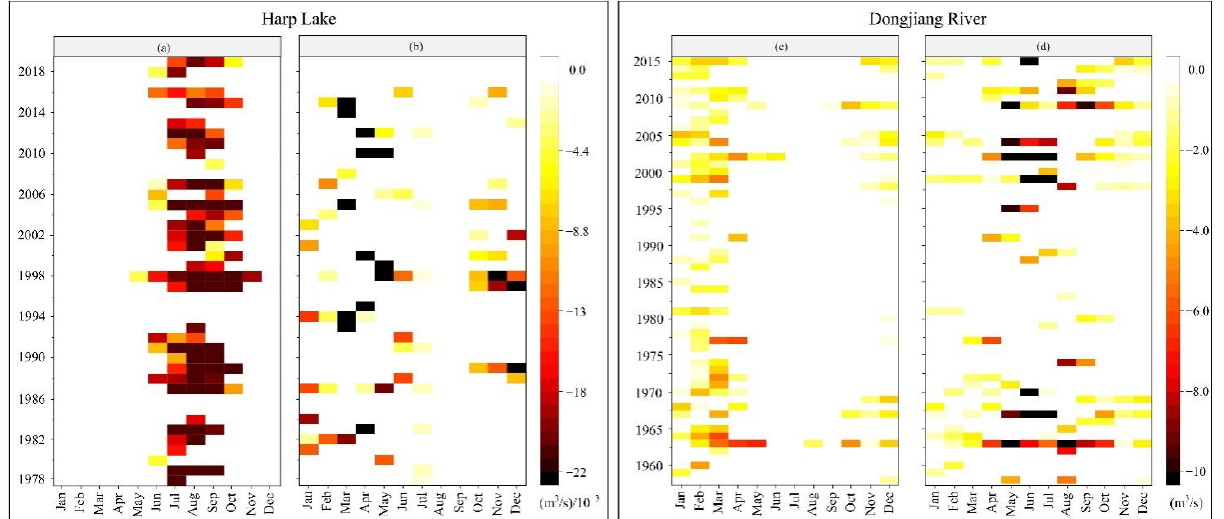
Figure 5. The distribution of streamflow deficit (i.e., the time series of Q − Q 20 ≤ 0) within a year, based on a fixed drought threshold ( FDT ) ( a , c ) and variable drought threshold ( VDT ) ( b , d ) at the HP0 station of Harp Lake catchment ( a , b ) and Dongjiang River catchment ( c , d ). The scaled legend bar on the right indicates the streamflow deficit in that month. The black grid in the figure shows that the streamflow deficit was lower than the minimum in the scaled legend.